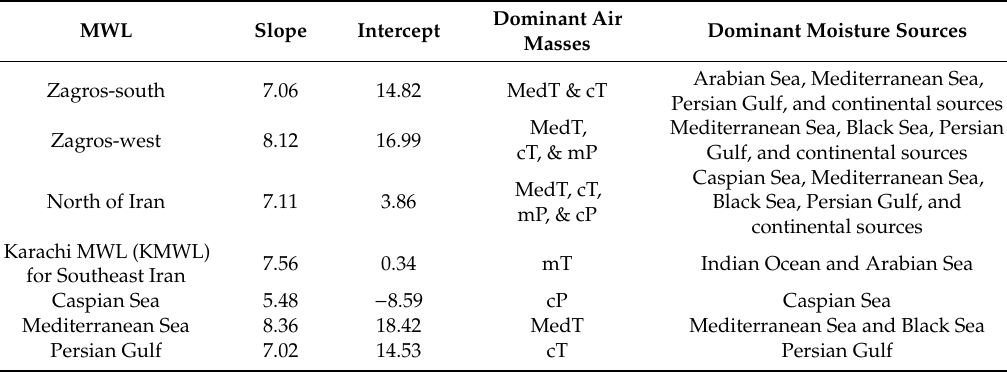
Table 1. Regional MWLs for Iran and MWLs for specific moisture